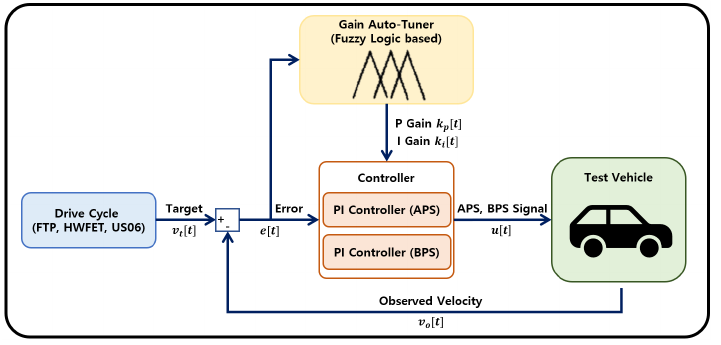
Figure 4. System Overview.